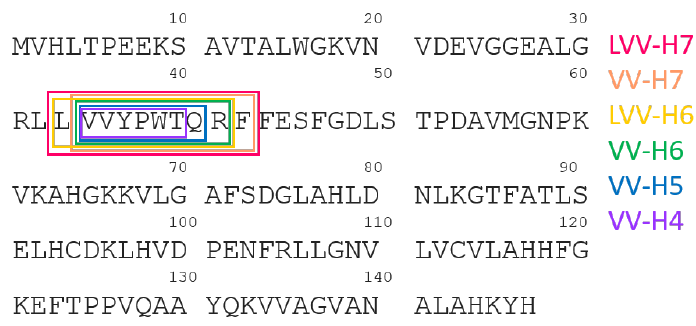
Table 1. Amino acid sequences of hemorphins.